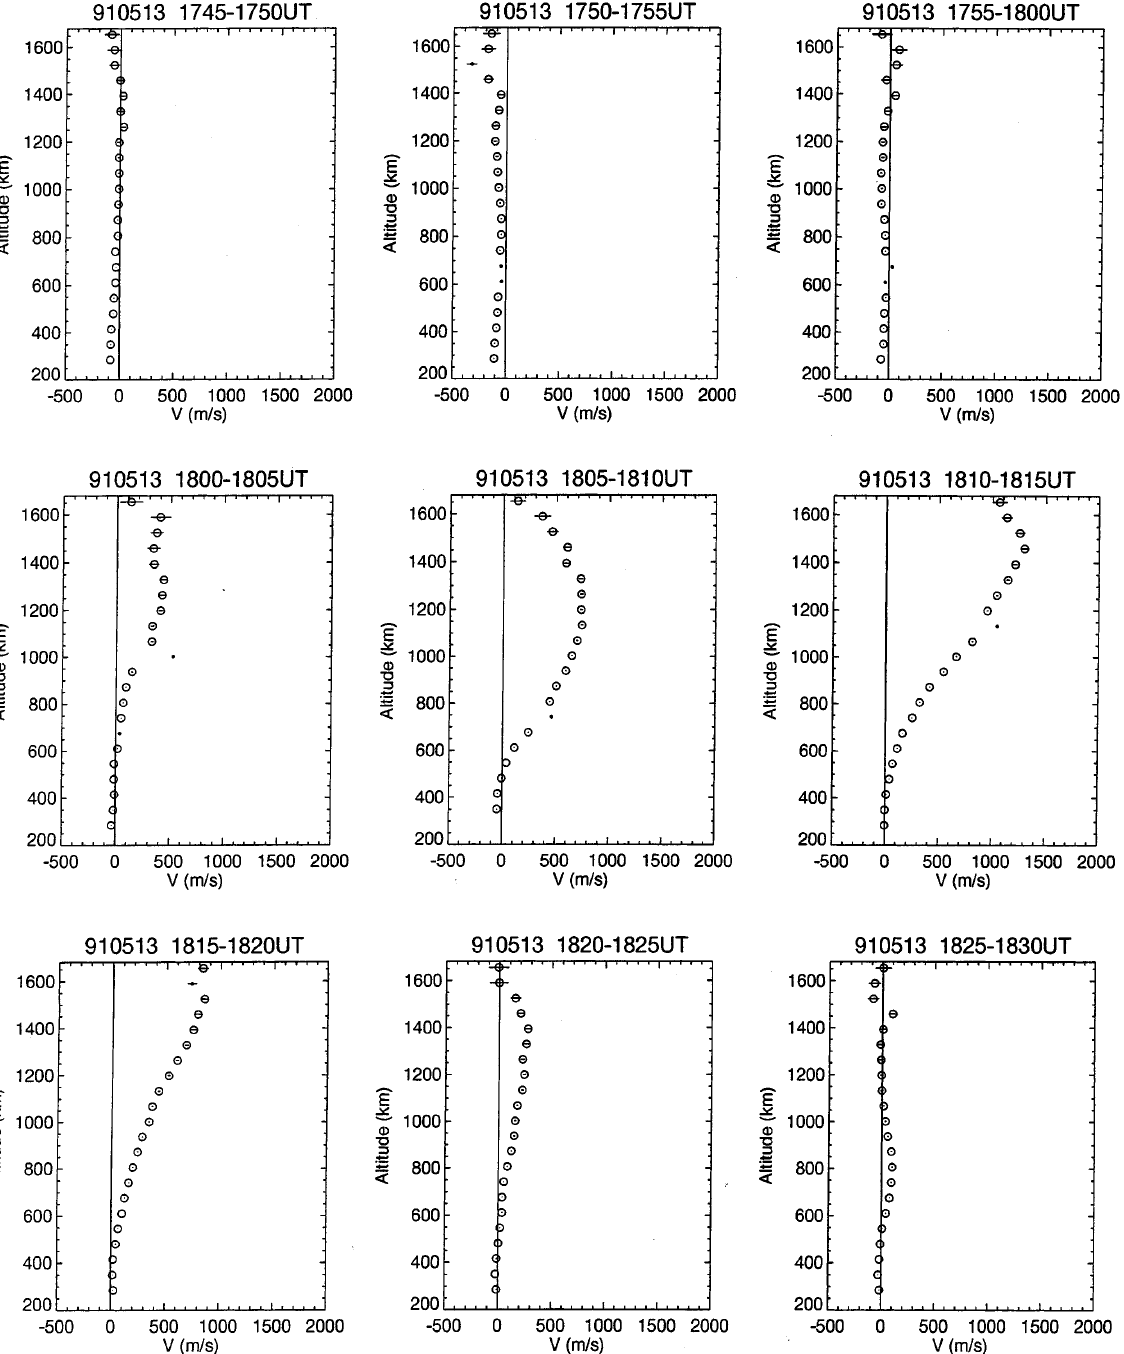
Fig. 1. a Typical examples of the ion upflow observed at 1745–1830 UT on May 13, 1991 and b ion downflow observed between 1940 and 2025 UT on September 26, 1990. Each figure contains 9 time sequential height profiles of the vertical ion velocity. The abscissa shows the vertical ion velocity where a positive ( negative ) value means